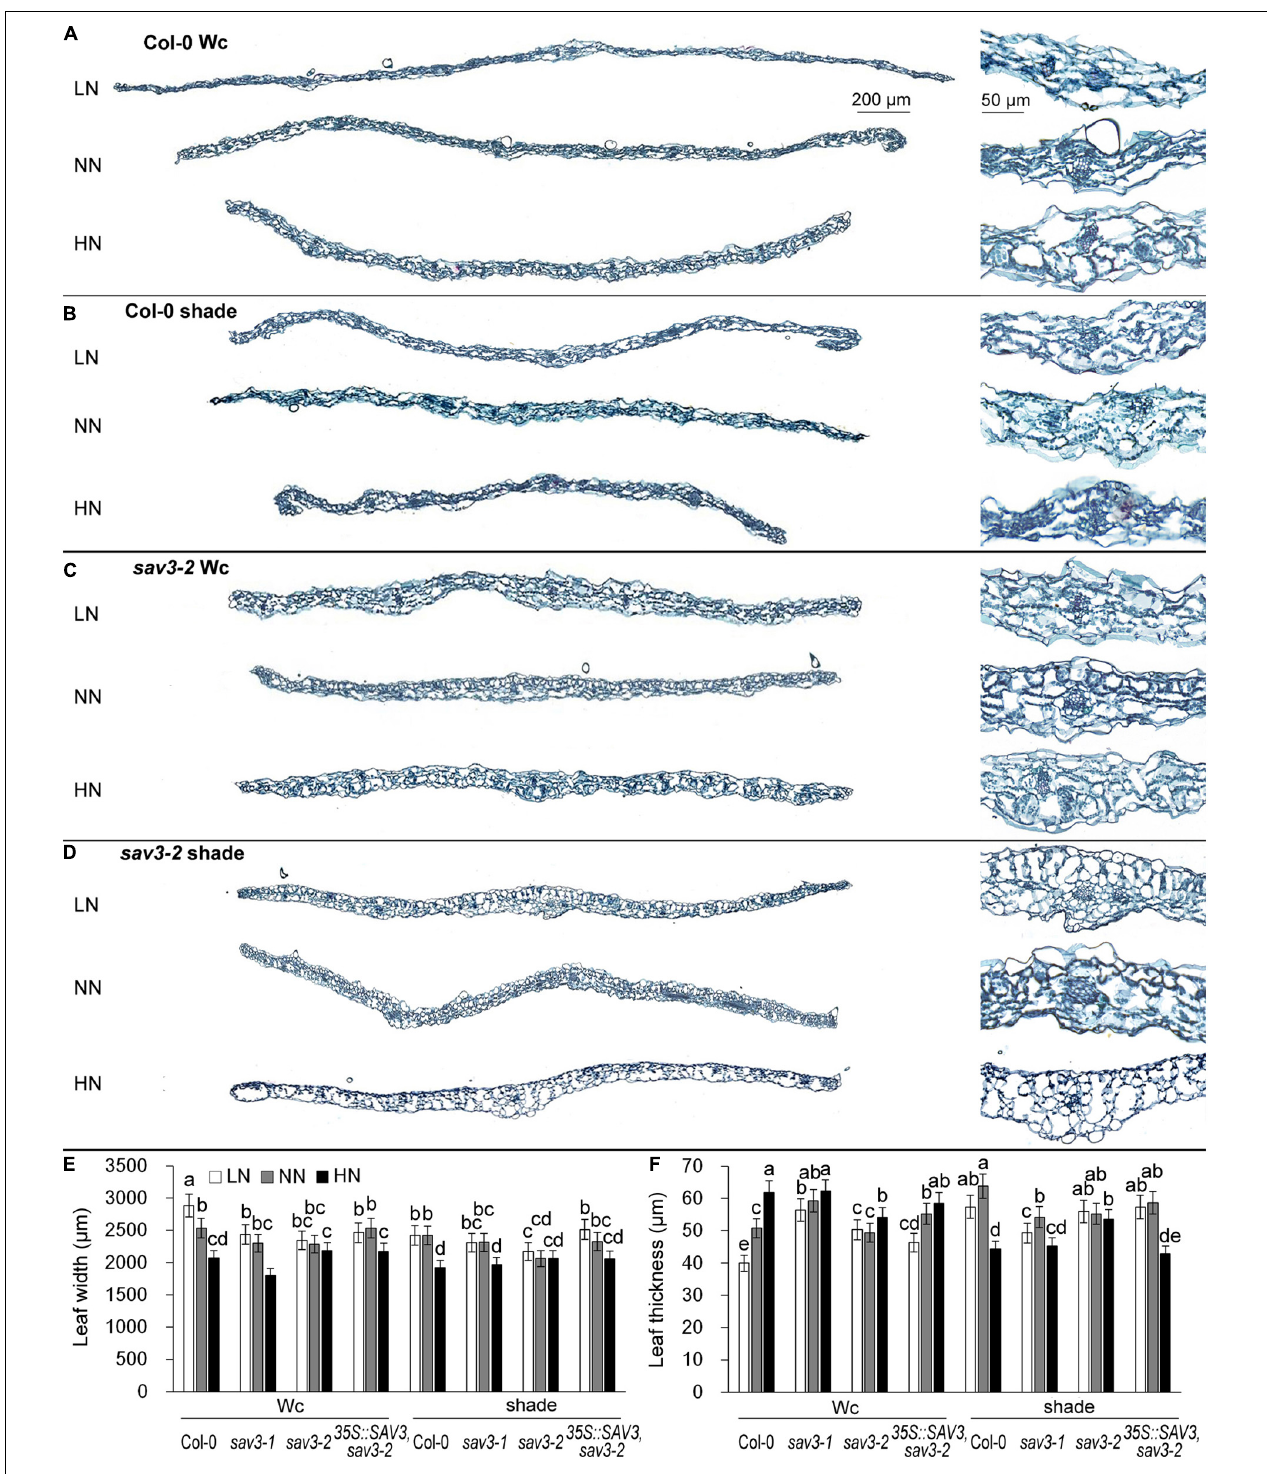
FIGURE 4 | High-N-induced leaf narrowing and thickening were reduced by shade treatment. Cross sections of 14-day-old wild-type (Col-0) and sav3-2 mutant leaves grown under different N levels and continuous white light (Wc) (A,C) or shade condition (B,D) . Local enlarged images of the leaf central vein are shown in the corresponding right panels. LN, low N condition; NN, normal N condition; HN, high N condition. (E) Maximum widths of 14-day-old wild-type (Col-0), sav3-1 , sav3-2 , and 35S::SAV3,sav3-2 leaves. (F) Average thicknesses of 14-day-old wild-type (Col-0), sav3-1 , sav3-2, and 35S::SAV3,sav3-2 leaves. Bars represent standard deviations of 15 independent replicates. Values followed by different letters are significantly different at P < 0.05 according to Duncan’s multiple range